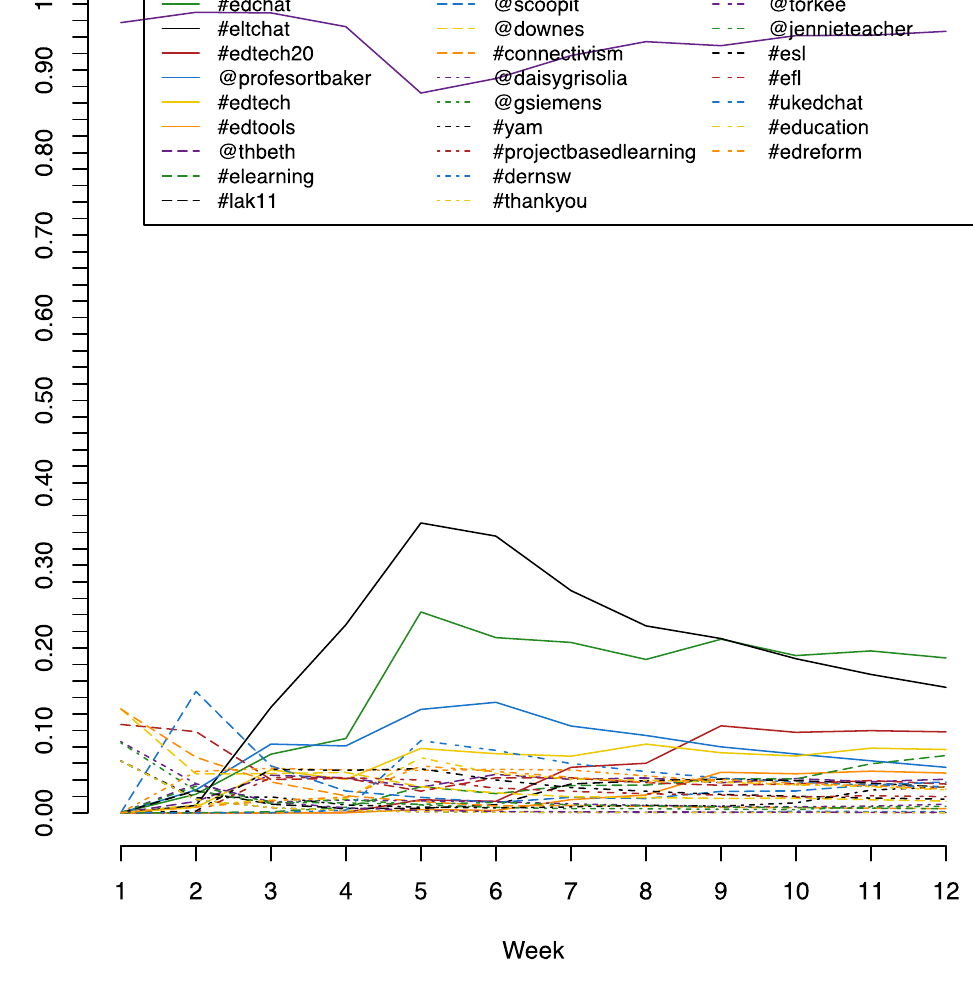
Figure 2. Variation of the authority weights for the top ranked social and technological nodes, over the twelve weeks of the course